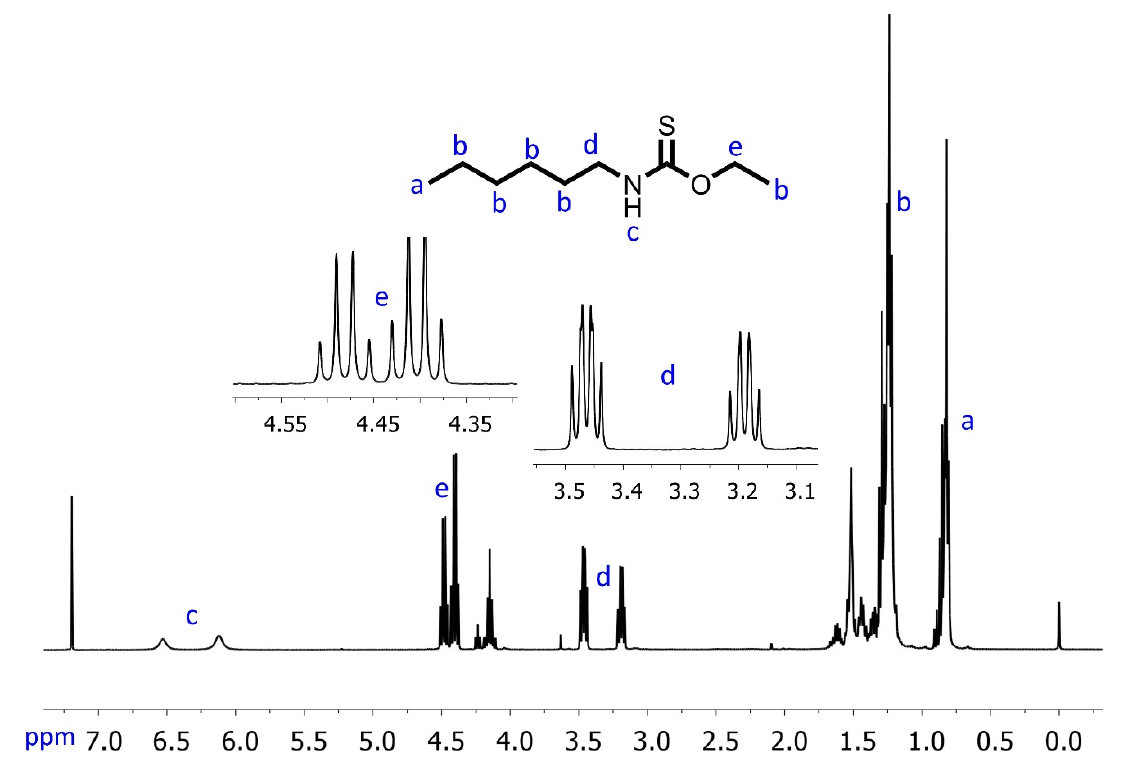
Figure 2. 1 H NMR spectrum (400 MHz) in CDCl 3 of the O -ethyl hexylcarbamothioate resulting from the aminolysis reaction with the star-shaped PNVCL polymers.